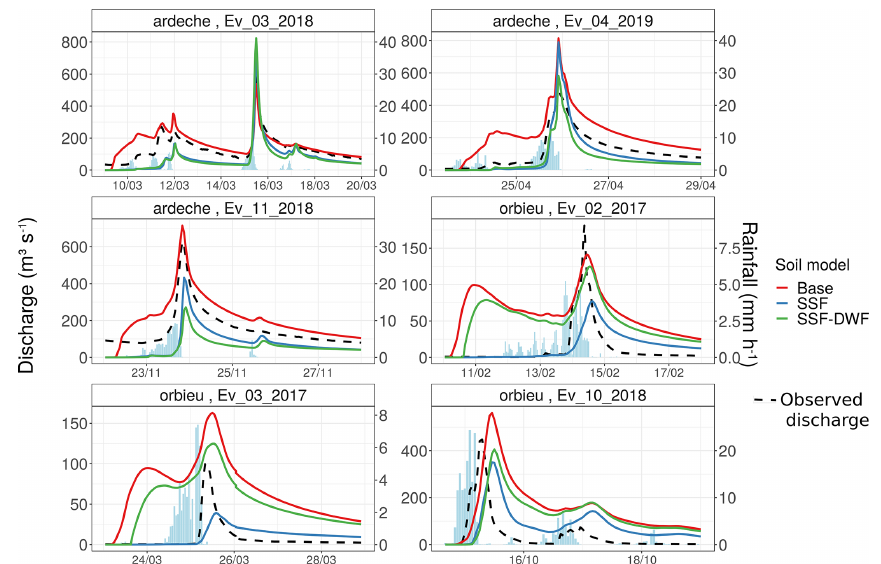
Figure 4. Discharges at the outlets of the Ardeche and Orbieu catchments for the six studied events simulated with MARINE using the base, SSF, and SSF–DWF models, and the observed discharges. Table 4. LNP and Nash–Sutcliffe efficiency (NSE) performance criteria for discharge simulation at the outlet for the six studied events over the two catchments for the base model (BM), the subsurface flow model (SSF), and the subsurface flow model coupled with the deep water model (SSF–DWF), referring to hourly observed